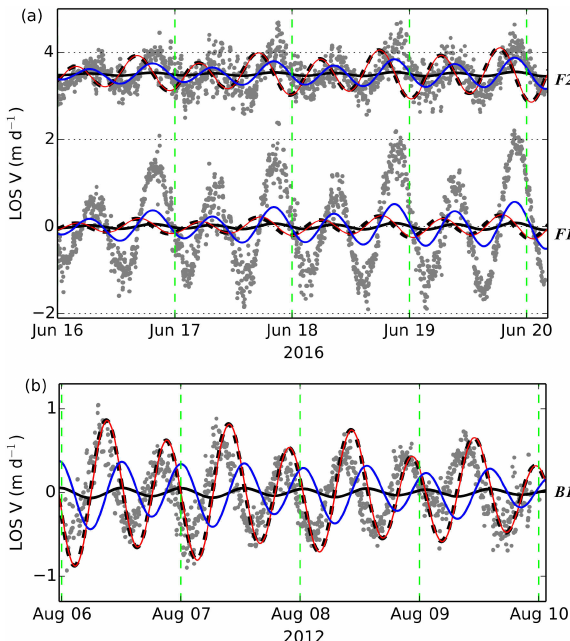
Figure 6. (a) Detrended LOS velocities of points located in the low- phase-lag zone in 2016. F1 and F2 are the two points marked with purple triangles in Fig. 4f; F2 (upstream one) has been offset by 3.5md − 1 for clarity. Grey dots are observed time series. Solid black curve shows vertical response to tide variations, using admittance of 0.15 (Podrasky et al., 2014) projected onto the LOS direction. Dashed black curve is horizontal response by using admittance of 0.12, projected onto the LOS direction. Red curve shows the sum of solid and dashed black curves; its Pearson correlation coefficient with observed time series is − 0.13 and − 0.19 for F1 and F2, re- spectively. Blue curve shows predicted LOS velocity by assuming ice is free-floating; its Pearson correlation coefficient with observed time series is 0.82 and 0.69 for F1 and F2, respectively. Note that ∼ 4days of data are used in this figure for clarity. (b) LOS veloc- ities of a point immediately adjacent to the glacier front in 2012 (B1 in Fig. 4b); colors and curves represent the same parameters as in (a) . The Pearson correlation coefficient with observed time series is 0.65 for the red curve (grounded or nearly grounded assumption, the same as Podrasky et al., 2014) and − 0.56 for the blue curve (free-floating